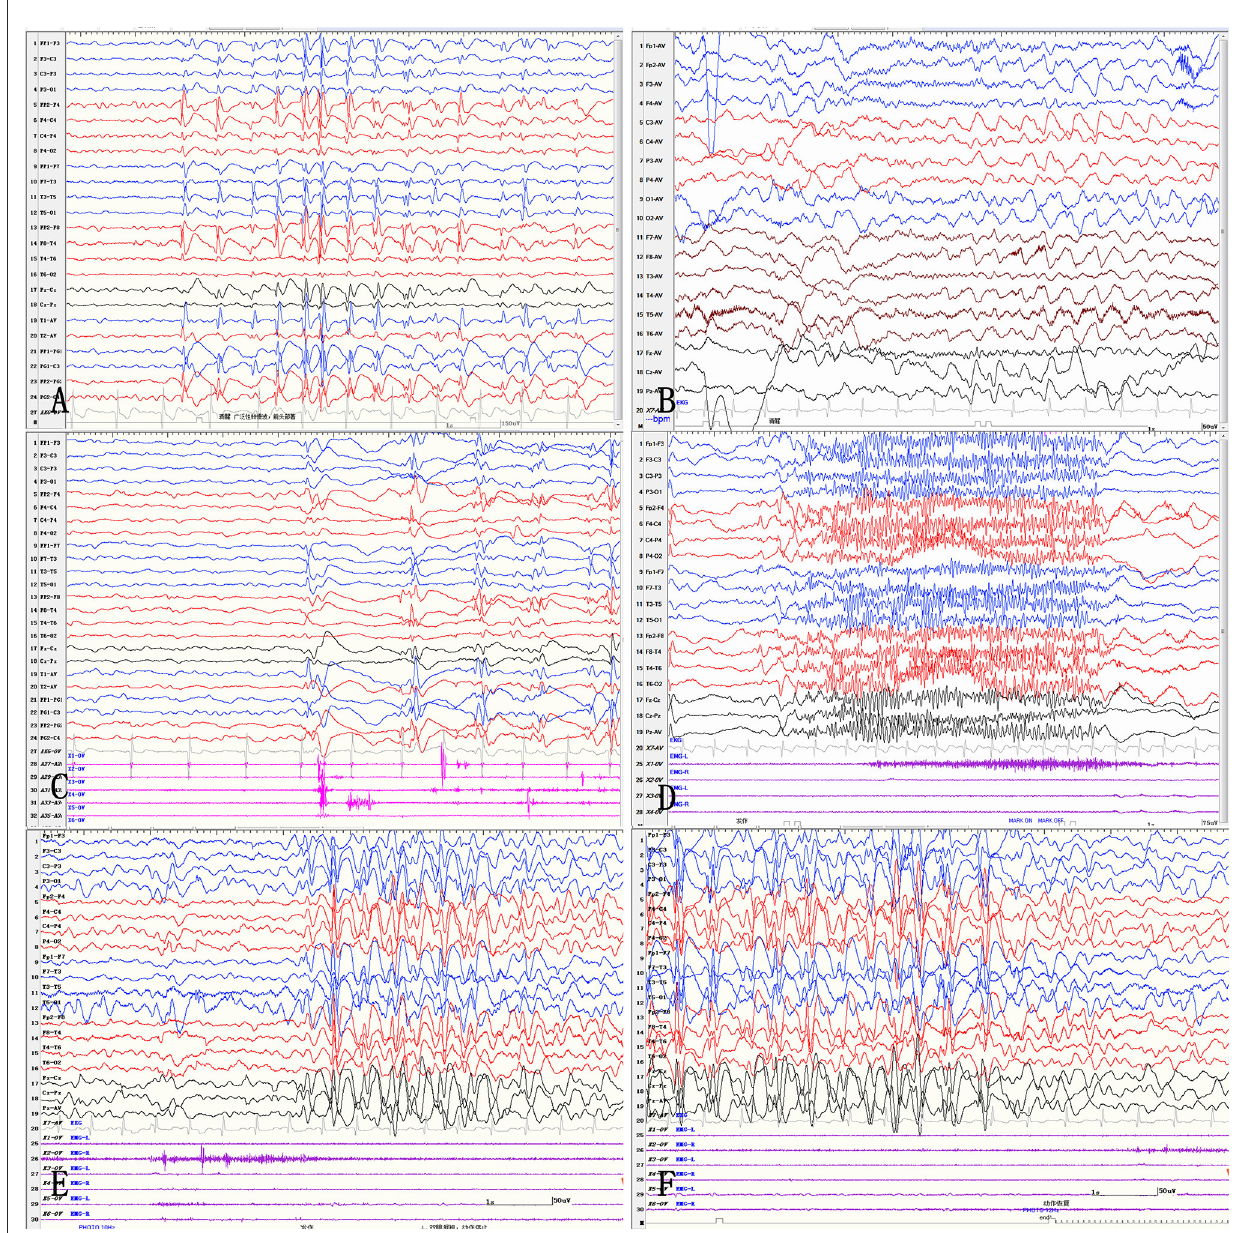
FIGURE1 Interictal and ictal EEG in LGS patients. Interictal EEG shows generalized 2.5–3Hz medium-high amplitude spike and slow waves, mainly located in the bilateral frontal regions (A) . Paroxysms of fast activities are shown on interictal EEG (B) . Myoclonic seizures show generalized sharp and slow waves (C) . Tonic seizures show generalized low-amplitude rhythms of spike waves (D) . Atypical absence seizures show diffuse, 2.5–3Hz medium-high amplitude spike waves and spike-and-slow wave discharges (E, F)